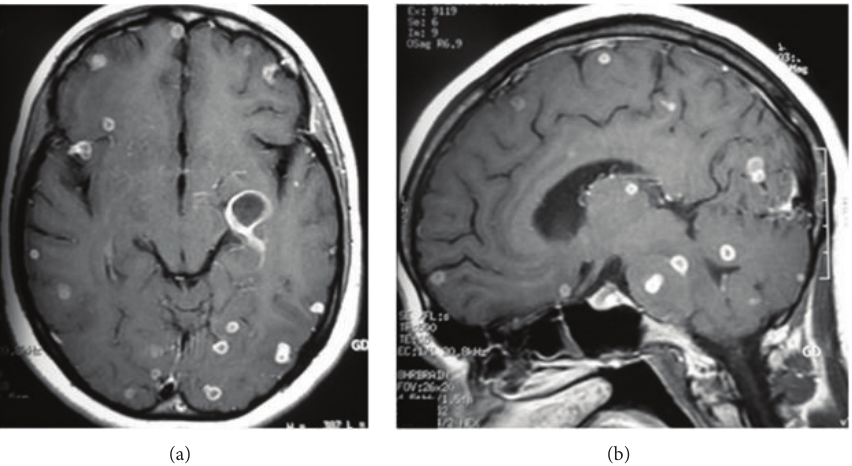
Figure 5: Multiple supra- and infratentorial tuberculomas in a 27-year-old female with history of pulmonary tuberculosis. Tuberculomas are seen as multiple small ring enhancing lesions without peripheral edema in axial and sagittal postcontrast T1-weighted MR